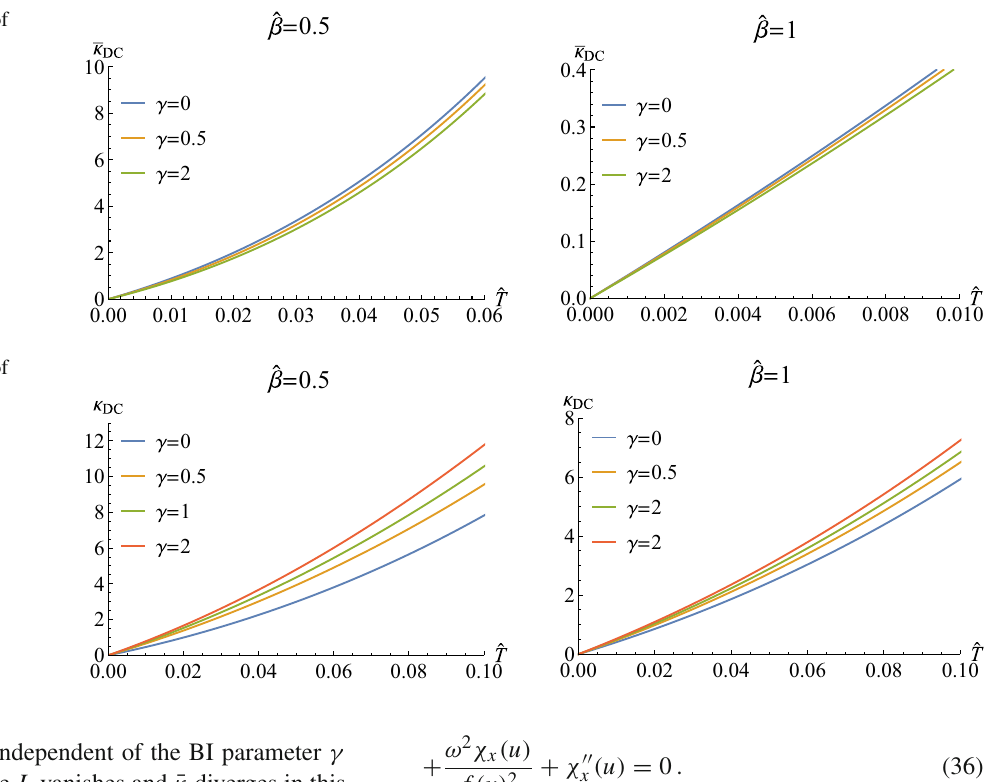
Fig. 3 ¯ κ DC as the function of ˆ T for some specific γ and ˆ β